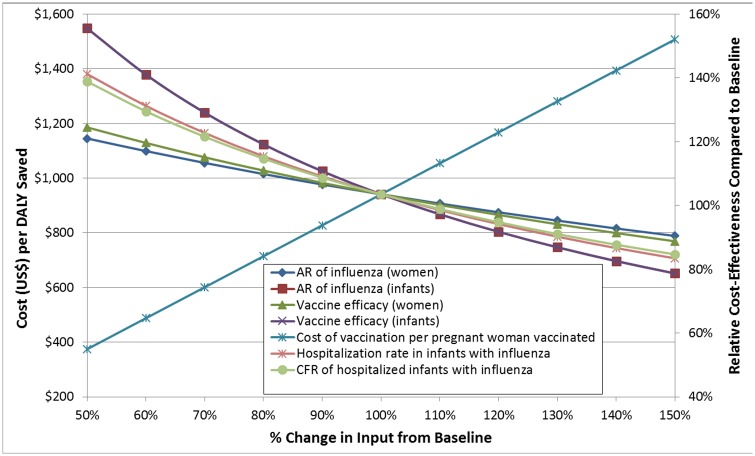
One-way sensitivity analysis of the base case.Each input variable is evaluated on a separate curve. The X-axis shows the percent change in the input variable from its baseline value (set at 100%), and the Y-axis shows the cost per DALY saved (left) and the relative change in the cost-effectiveness ratio from its initial value (right). Moving down in the Y-axis indicates a lower cost per DALY, i.e. a more efficient intervention. The greater the slope of each curve, the more sensitive the baseline model is to changes in that variable. The 7 most sensitive variables are depicted here.